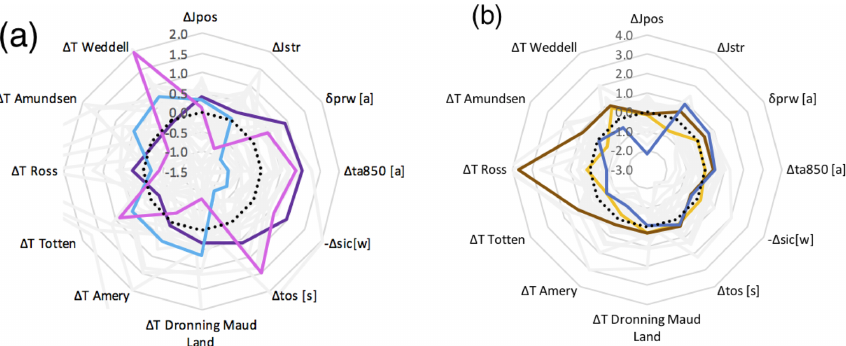
Figure 4. Normalized projected 21C changes for Antarctica (with model ensemble in gray and the median in black). (a) Top three: CCSM4 (pink), MIROC-ESM-CHEM (purple), and NorESM1-M (light blue). (b) Top four to six: CSIRO-Mk3-6-0 (yellow), HadGEM2-ES (brown), and IPSL-CM5A-M (dark